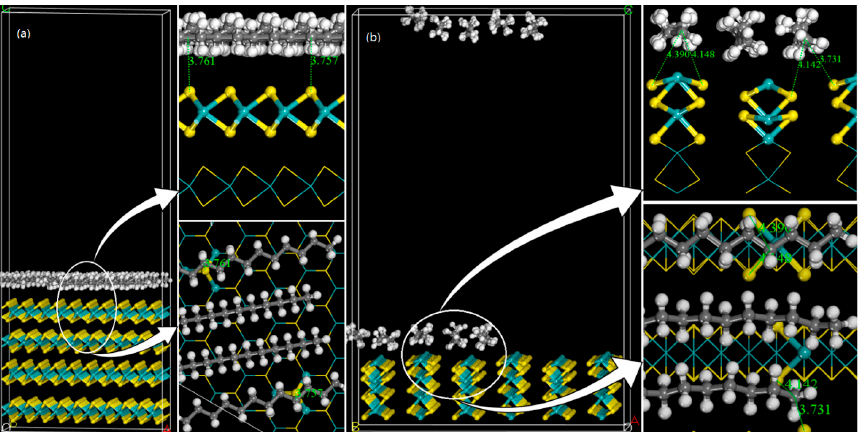
Figure 3. The adsorption behavior of SCA on the surface of molybdenite. ( a ) SCA and MS001; ( b ) SCA and MS100. SCA and